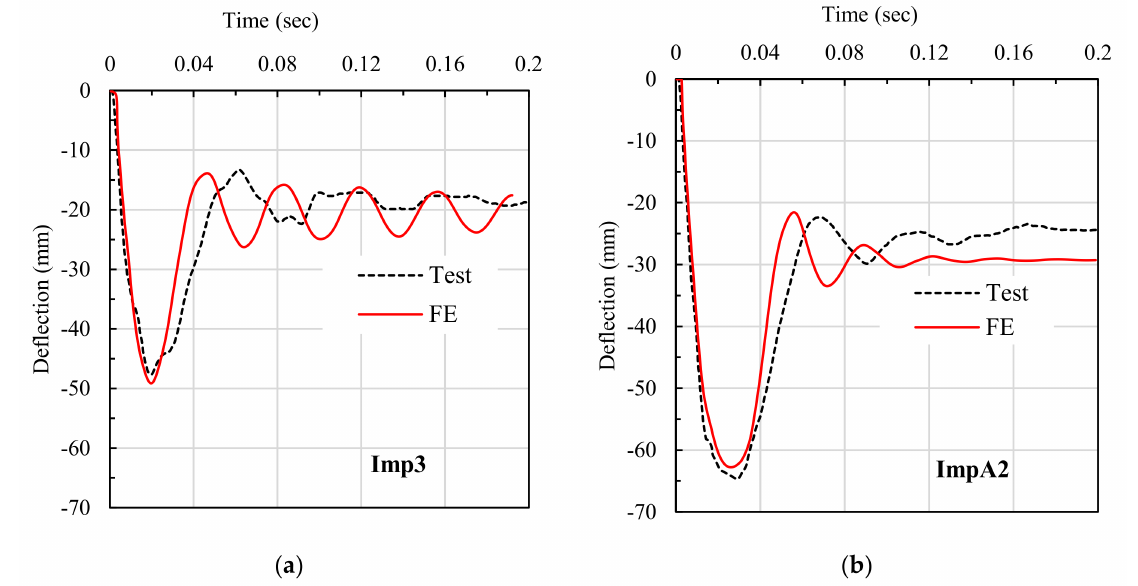
Figure 5. Deflection − time history of the RC column at a point 2000 mm away from left support: ( a ) column Imp3; ( b ) AFRP-retrofitted column